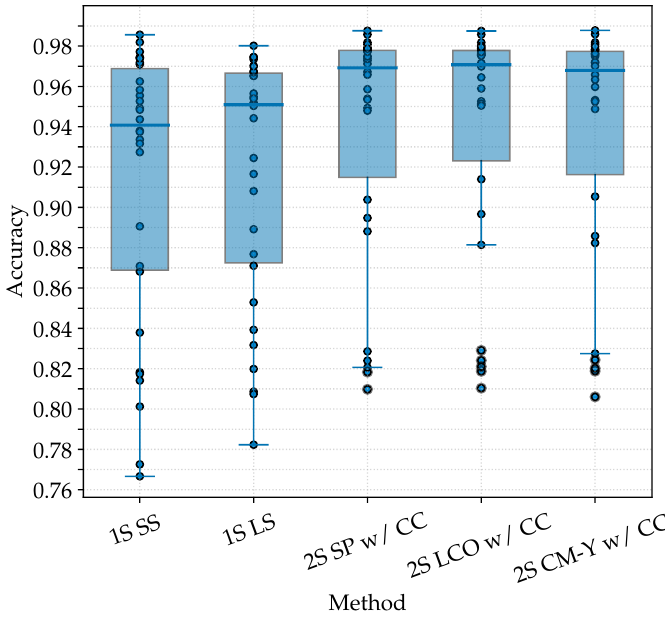
Figure 8. Boxplots depicting the overall results compared amongst the different methods. The highest overall median accuracy is achieved by the 2S LCO w/ CC method, where the full pipeline with Local Coordinate Optimization and Confidence Comparison was